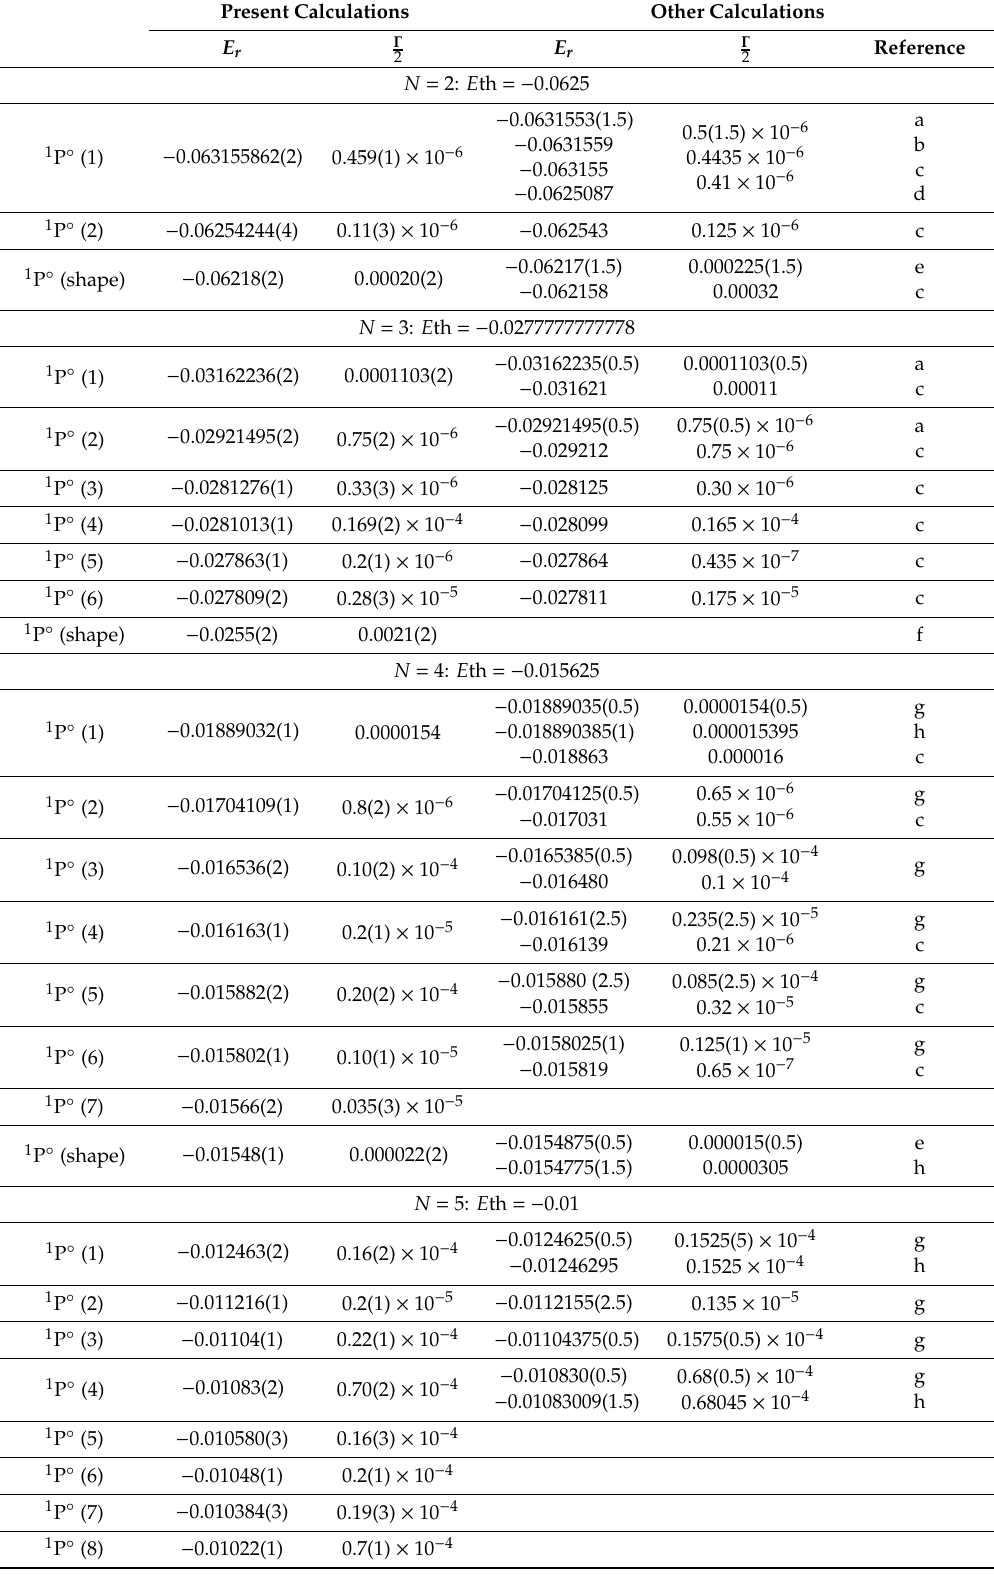
Table 1. The 1 P ◦ Feshbach and shape RPs (in a.u.) in Ps − associated with the N = 2, 3, 4, 5 Ps thresholds. The numbers in the parentheses denote the uncertainty in the last